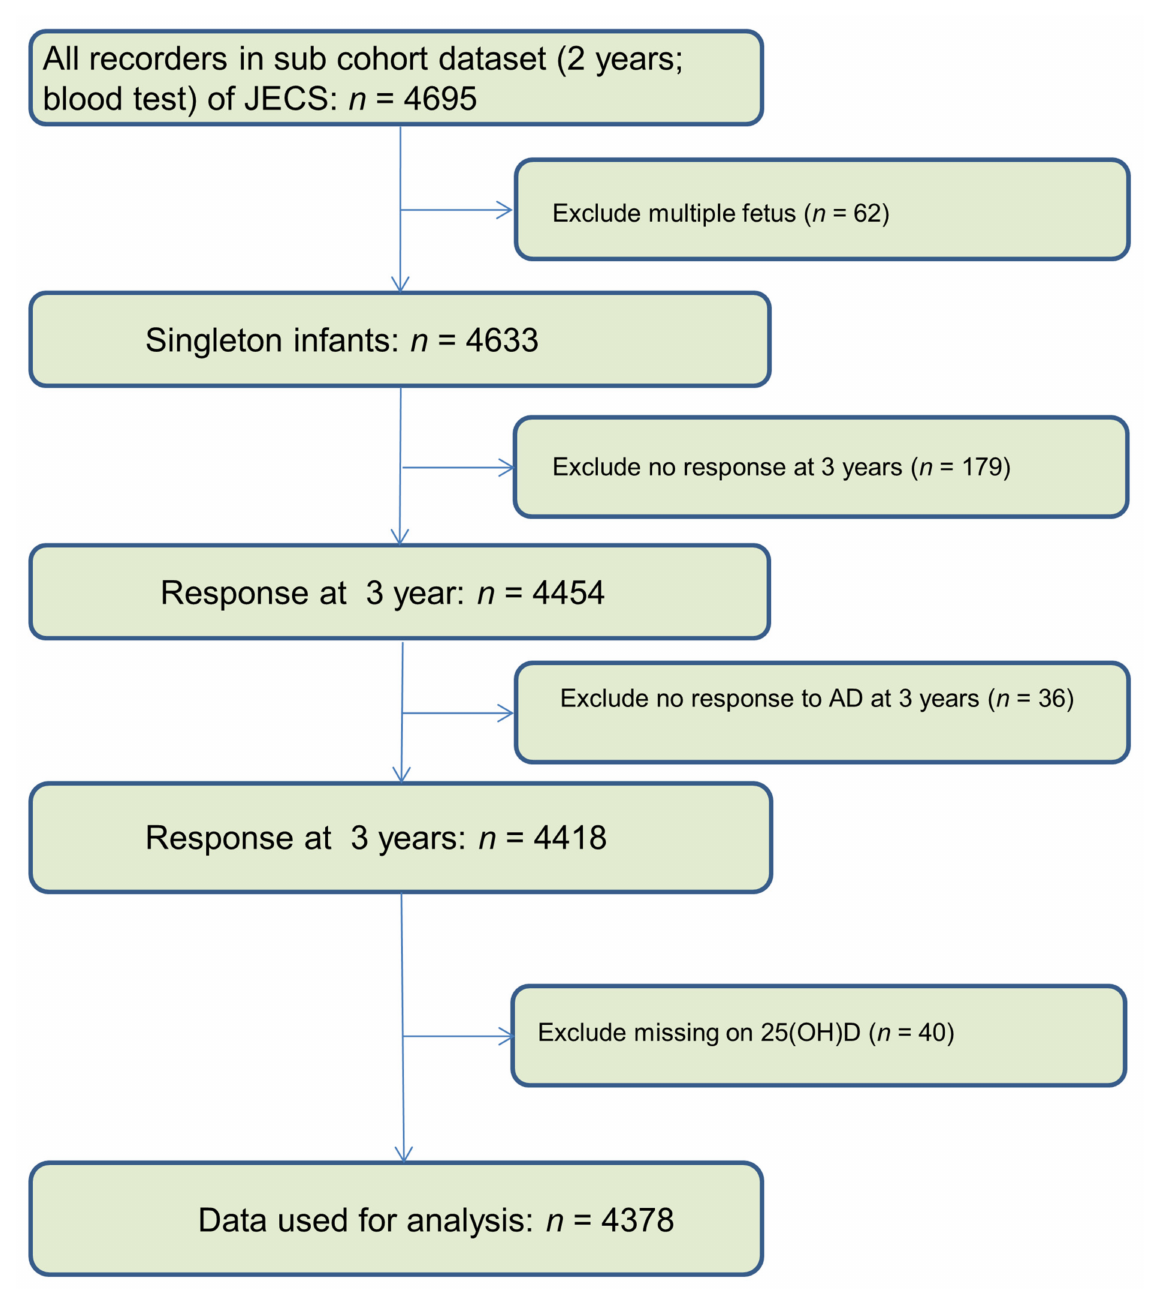
Figure 1. Flow chart of data